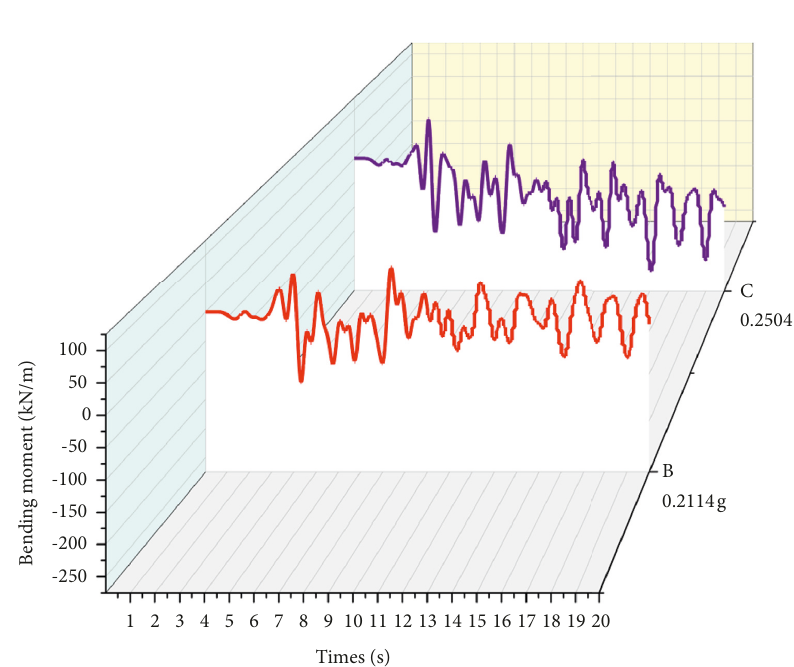
Figure 10: Top of pile bending moment for time-history curve-b.